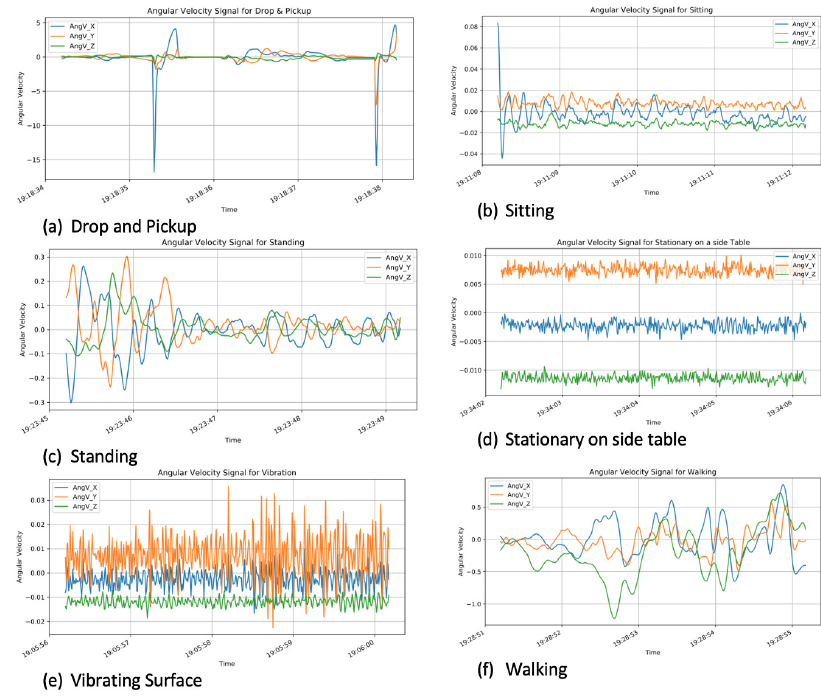
Figure 4. Angular velocity signals for the six